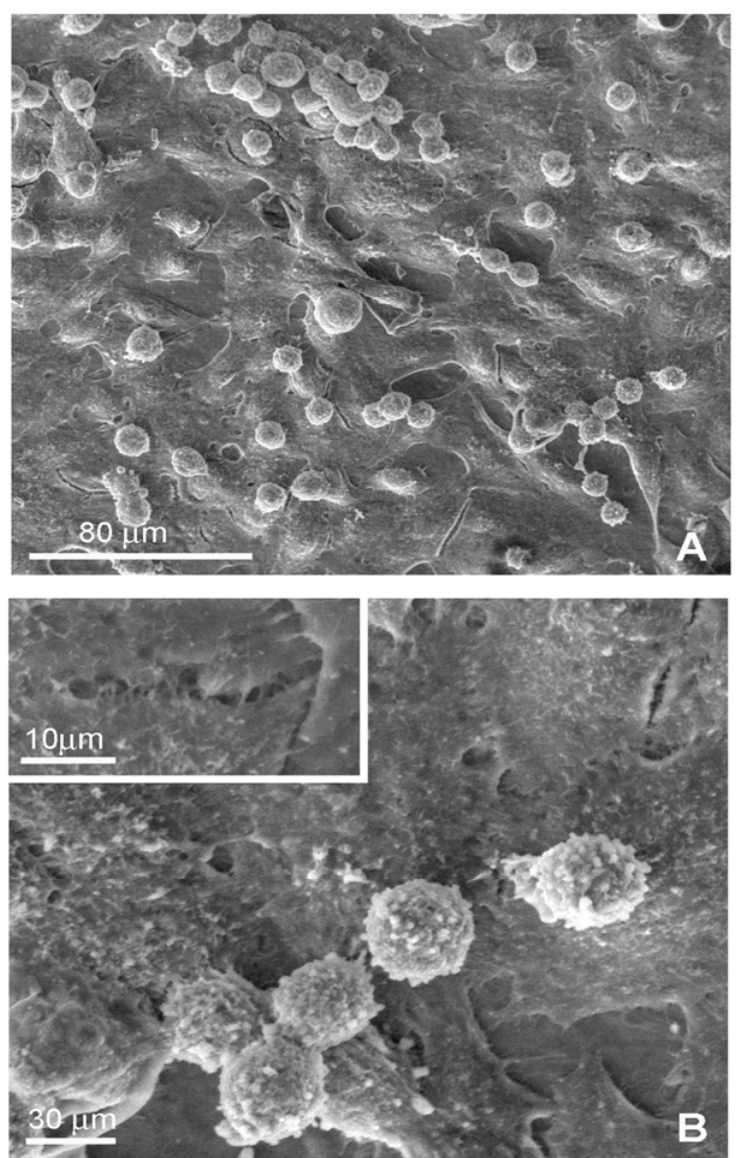
Figure 5. Environmental Scanning Electron Microscopy (ESEM) of J111 cells grown for 3 days on collagen membrane C2T25 at low (A) and high (B)